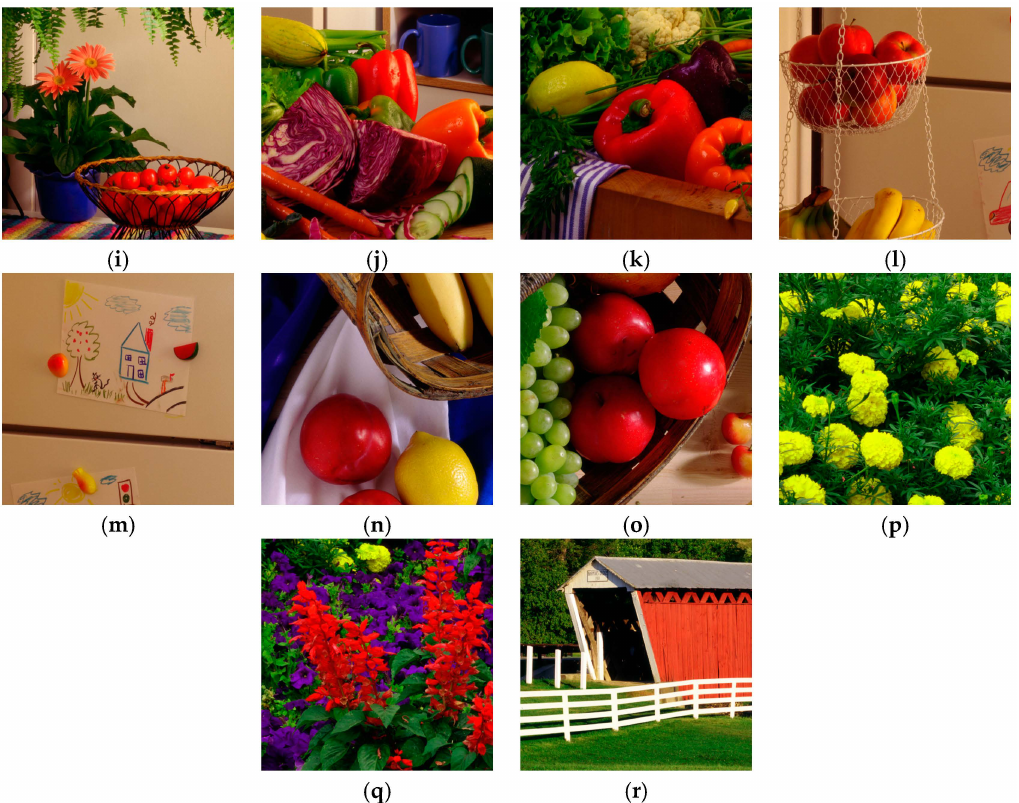
Figure 6. The MCMaster dataset